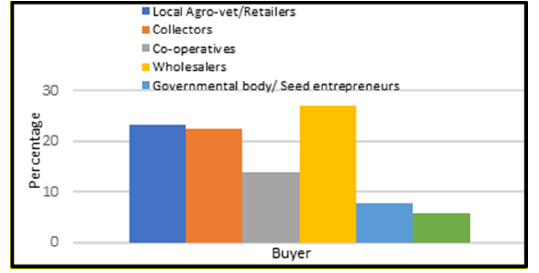
Figure 21. Buyer of vegetable